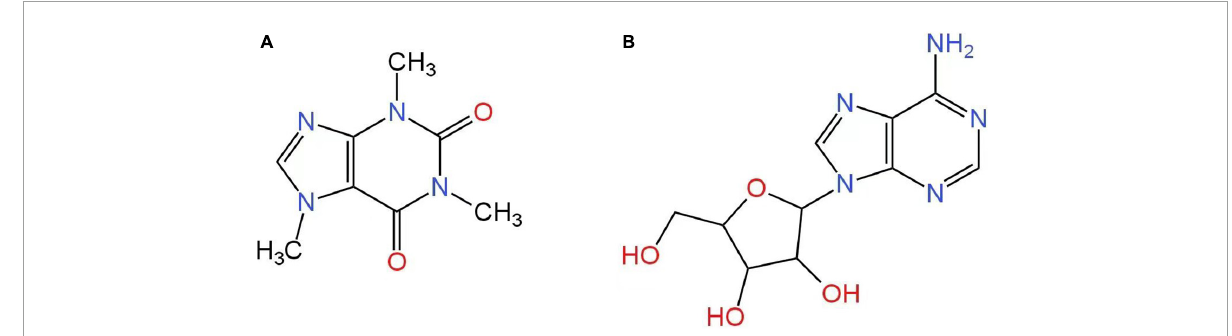
FIGURE1 Chemical structures of caffeine and adenosine. The structure of caffeine (A) is similar to that of adenosine (B) due to the purine